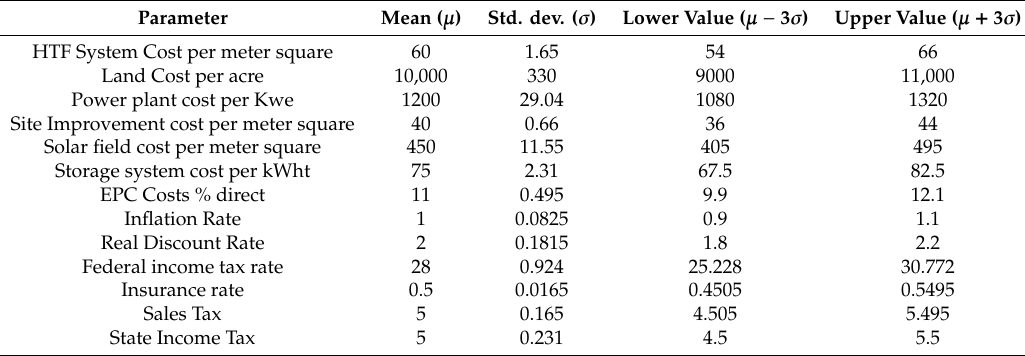
Table 2. Uncertain variables with mean, std. dev. and